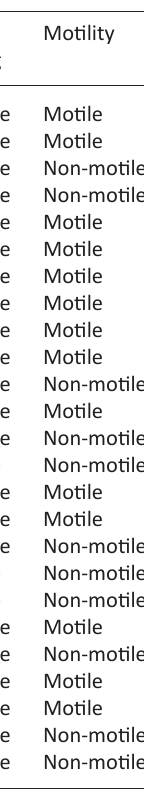
Table 2. Morphological characteristics of